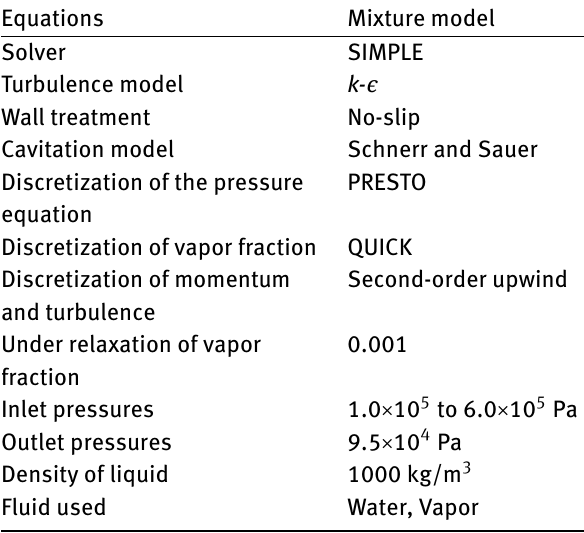
Table 1: ANSYS FLUENT solver